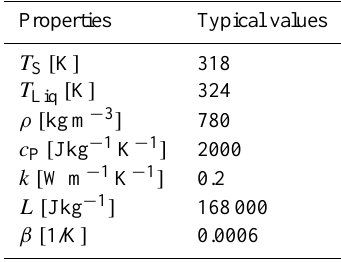
Table 1. Complimentary specifications of the heat exchanger. Table 2. Thermophysical properties of